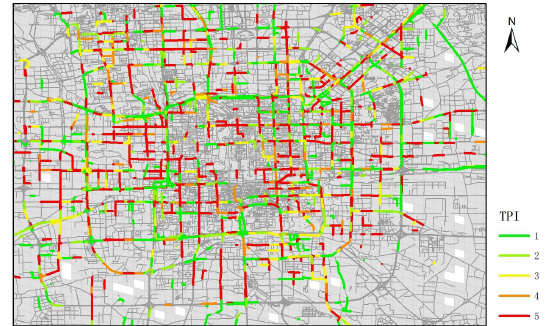
Figure 11. TPI at 10 a.m. from Monday to Thursday